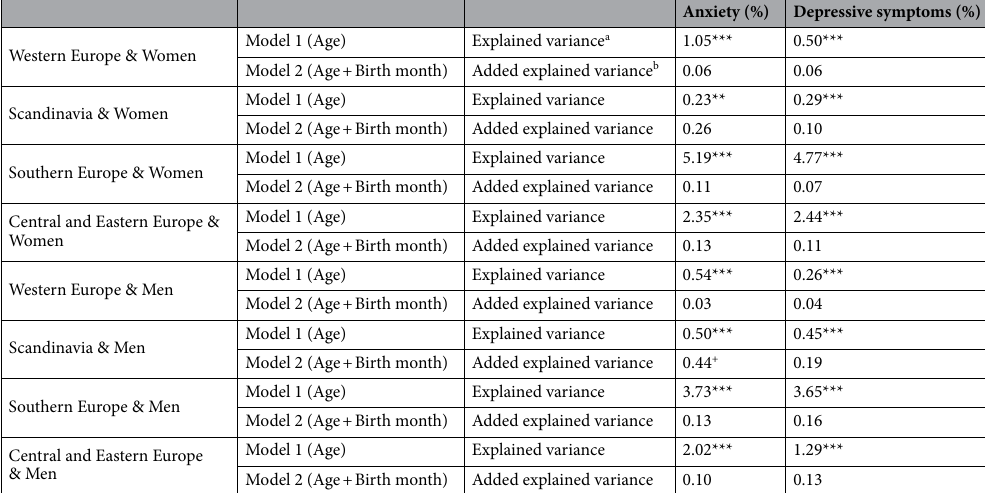
Table 4. Variance explained by Age (Model 1) and Month of birth added (Model 2) across sex and European regions. a Explained variance is significant if the F statistic is significant of Model 1. b Added explained variance is significant if the F change is significant between Model 1 and Model 2. + p < .1; **p < 0.01; ***p <